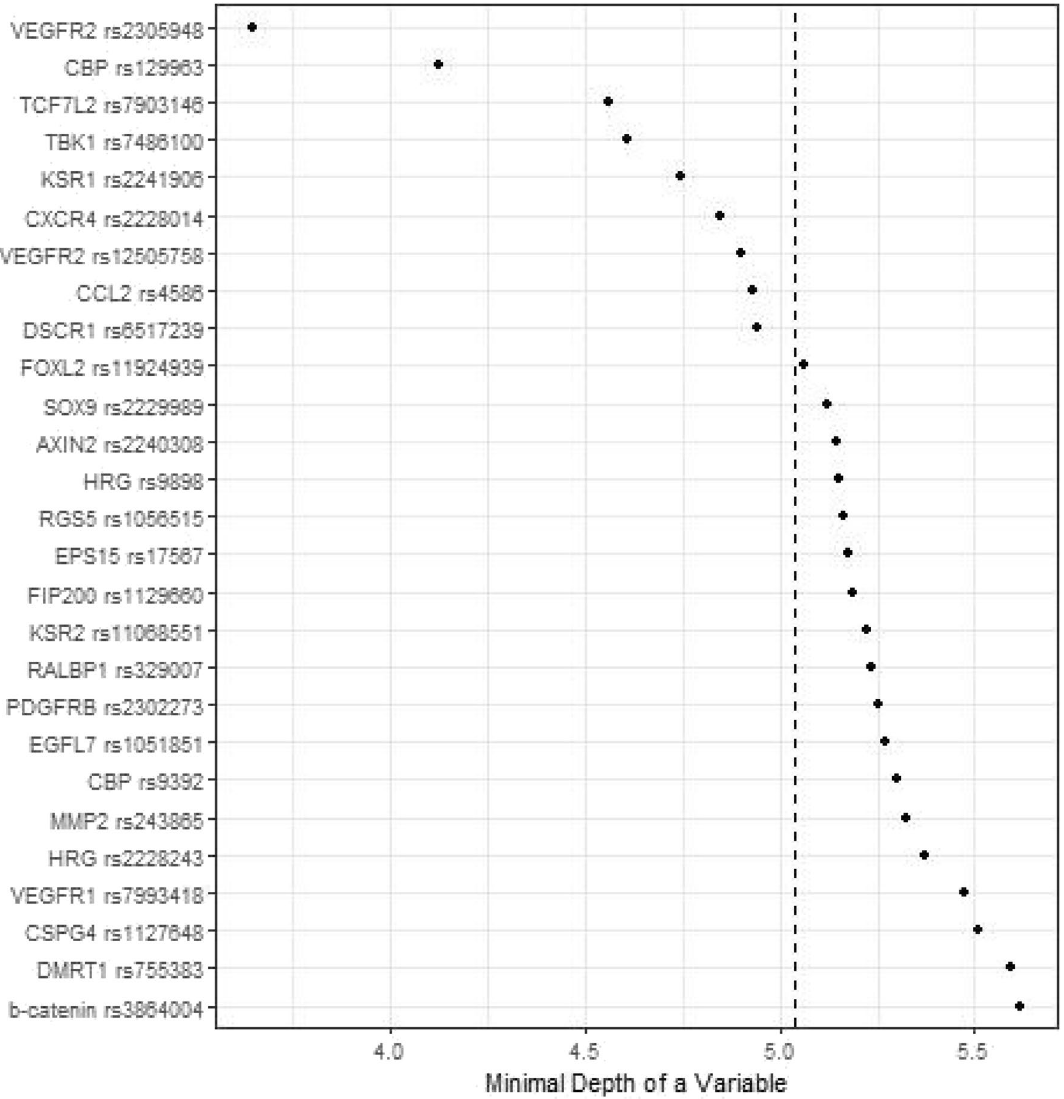
Figure 2. Minimal depth plot of 27 SNPs predicting OS in KRAS wild-type mCRC patients. The most predictive SNPs in order of importance are CBP rs129963, TBK1 rs7486100 and VEGFR2